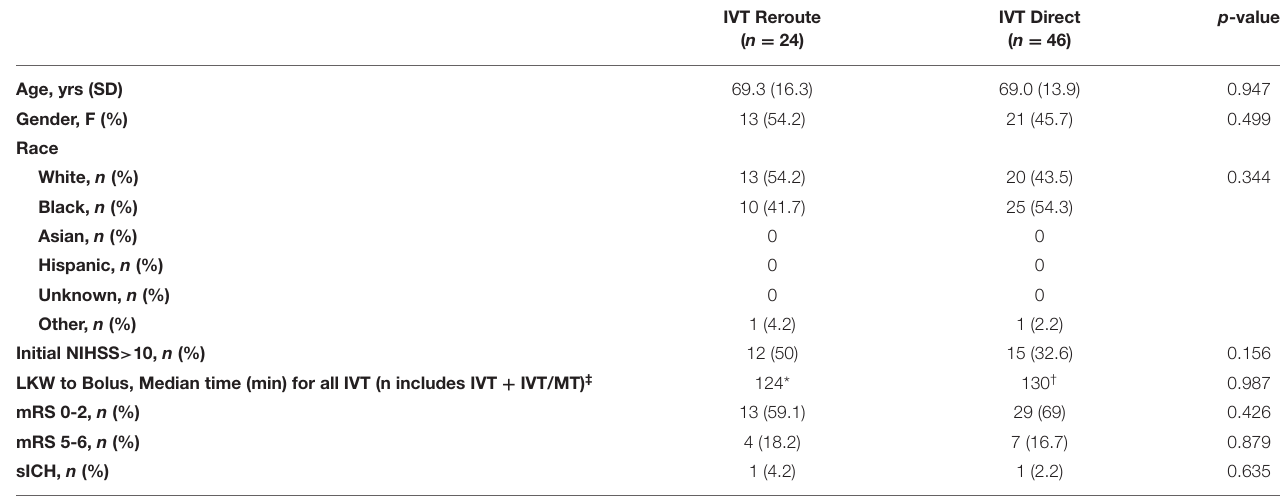
TABLE 5 | Demographics and outcomes of IVT by mode of arrival (reroute vs. direct to